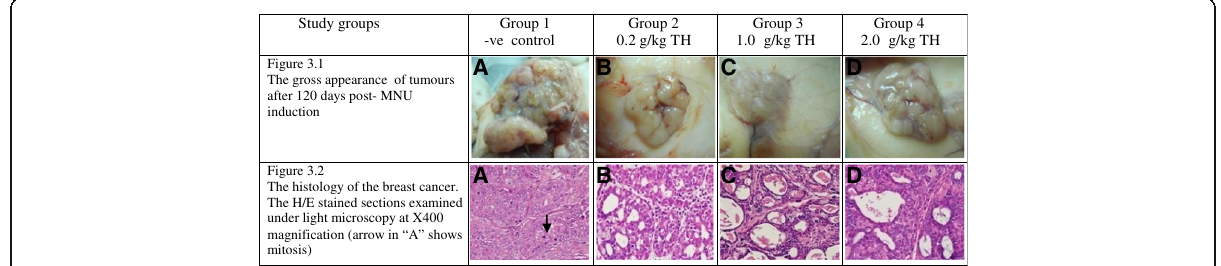
Figure 3.2 The histology of the breast cancer. The H/E stained sections examined under light microscopy at X400 magnification (arrow in “A”shows mitosis) Fig. 3 The gross morphology and histology of the breast tumors of rats in various TH-treated groups compared to the untreated negative control. The H/E stained sections were examined under light microscopy at X400 magnification. The majority of tumors in untreated negative control group were of grade III with increased heterogeneous nuclei formation and mitotic activity (plate A, arrow) compared to tumors in TH treatment groups which were of grade I and II (less aggressive) (Fig. 3.2); A = − ve control, B = 0.2 g/kg TH, C = 1.0 g/kg TH and D = 2.0 g/kg TH. Legends: TH = Tualang honey, MNU = 1-methyl-1-nitrosourea, − ve = Negative control (group that received tumor induction but no honey